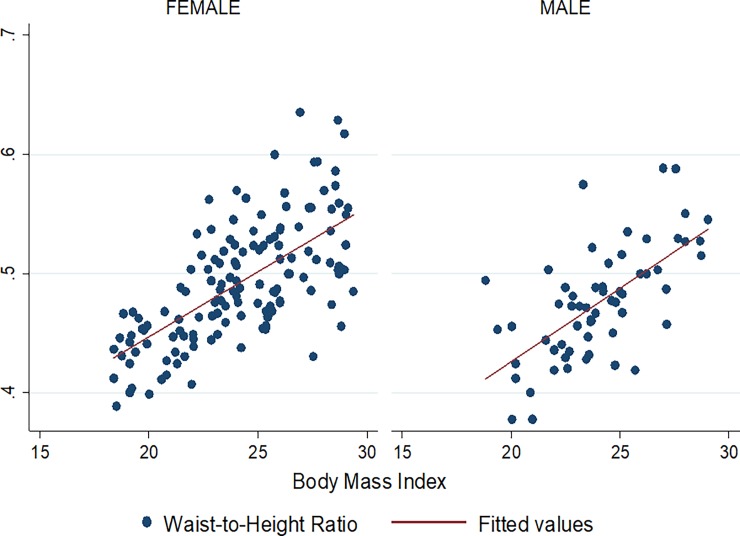
Linear regression model of the association between WHtR and BMI in females and males.